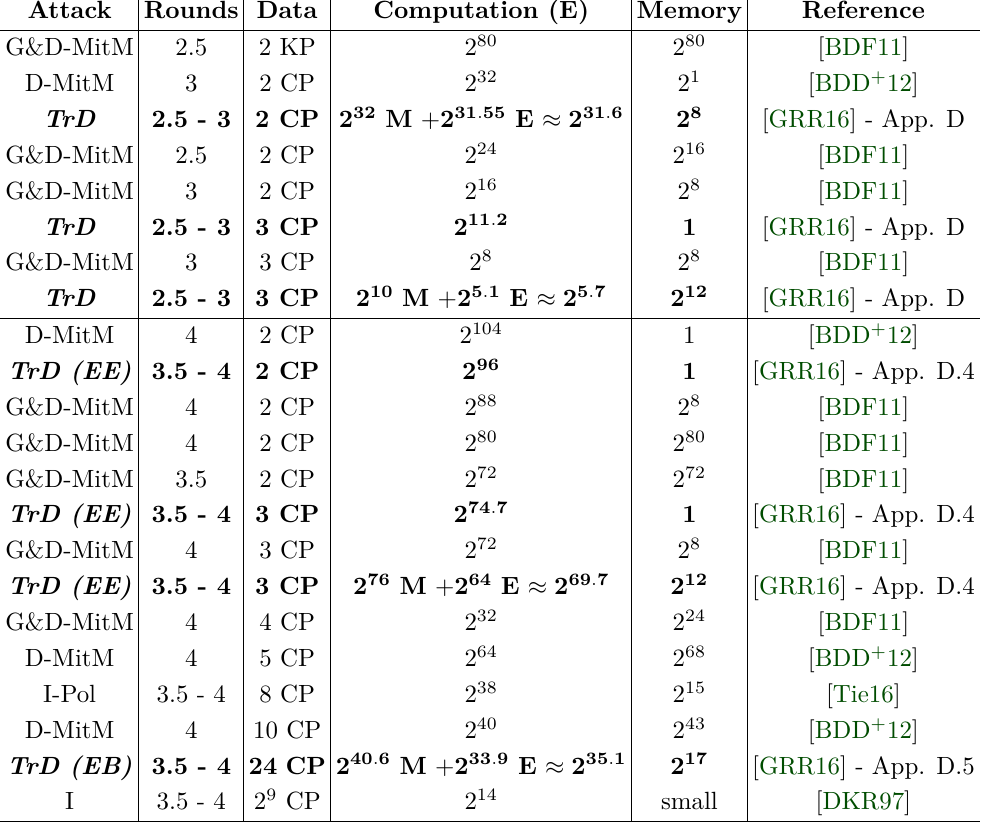
Table 2: Comparison of low-data attacks on round-reduced AES. Data complexity is measured in number of required known/chosen plaintexts (KP/CP). Time complexity is measured in round-reduced AES encryption equivalents (E) and in memory accesses (M). Memory complexity is measured in plaintexts (16 bytes). The case in which the MixColumns operation is omitted in the last round is denoted by “ r. 5 rounds”, that is r full rounds and the final round. New attacks are in